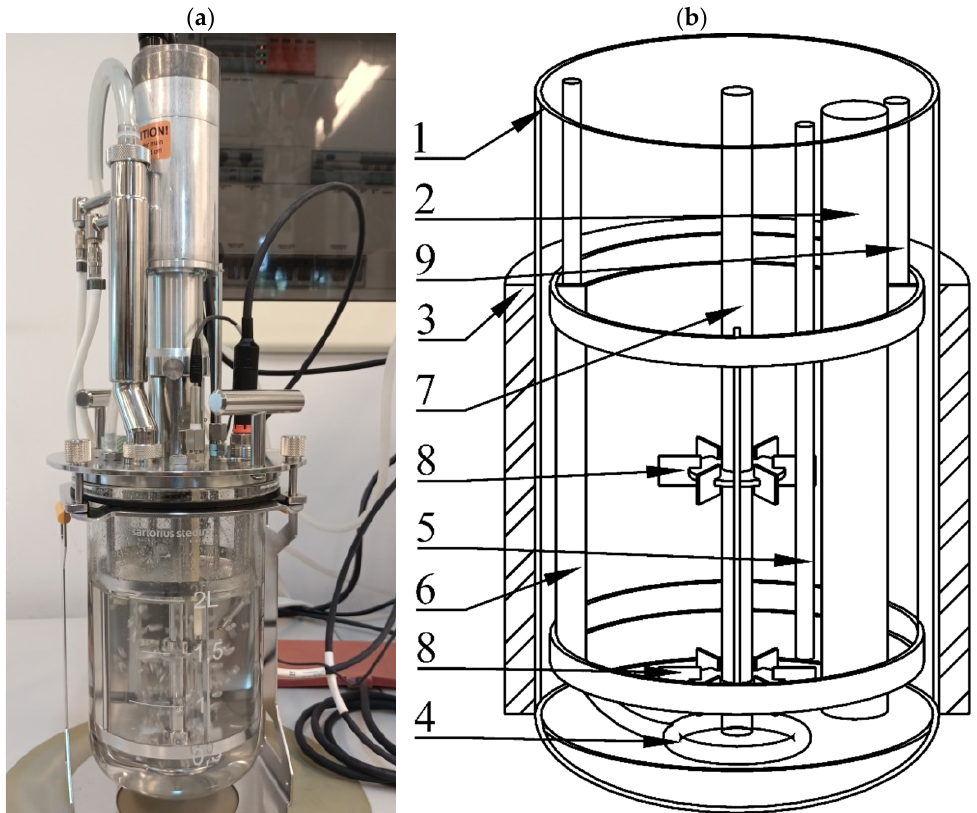
Figure 1. Experimental setup: ( a ) real view of the bioreactor, ( b ) bioreactor vessel scheme: 1–glass tank, 2–internal cooler, 3–external heating coat, 4–gas sparger, 5–temperature sensor, 6–baffles, 7–impeller shaft, 8–Rushton-type turbine, 9–injection port.